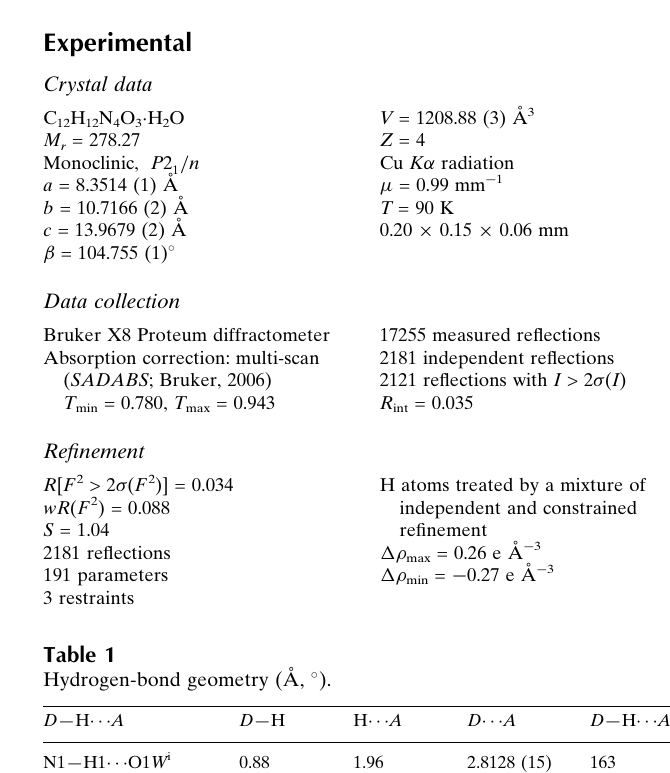
Hydrogen-bond geometry (A˚ , (cid:2) ). D —H (cid:1)(cid:1)(cid:1) A